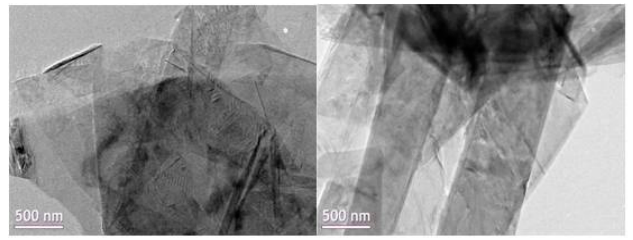
Figure 8. Transmission electron microscope (TEM) images of the raw GN. Figure 9. Transmission electron microscope (TEM) images of the raw GN. Metals 2016 , 6 , 234